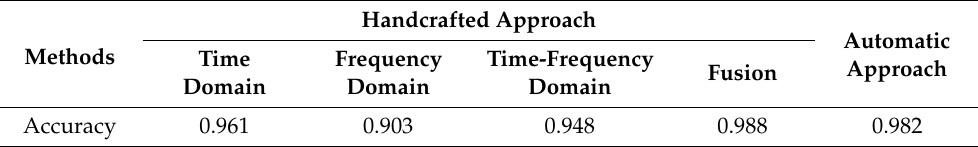
Table 2. Performance comparison of the handcrafted features approach and the automatic approach.